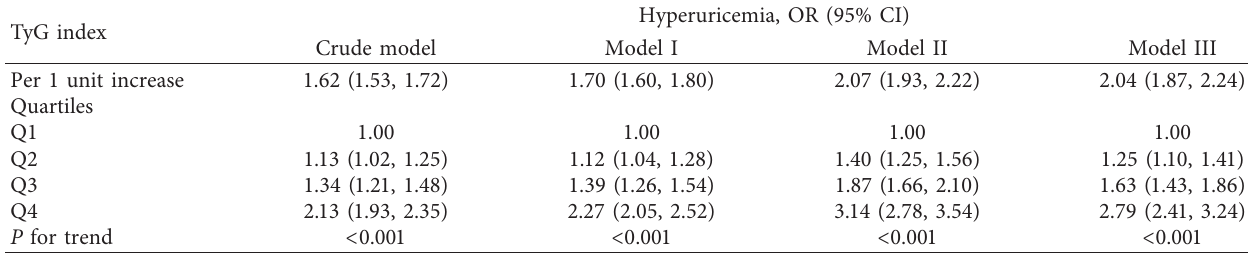
Table 3: Association between the TyG index and HUA in different models.